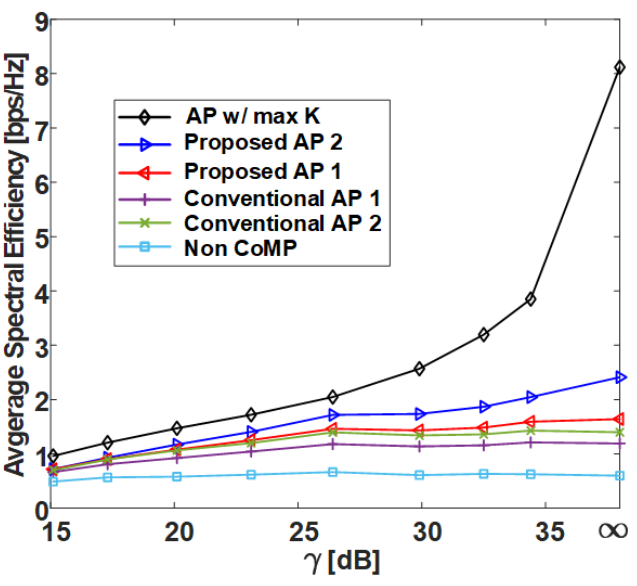
Figure 11. Average spectral efficiency of various clustering schemes with respect to γ in uniform